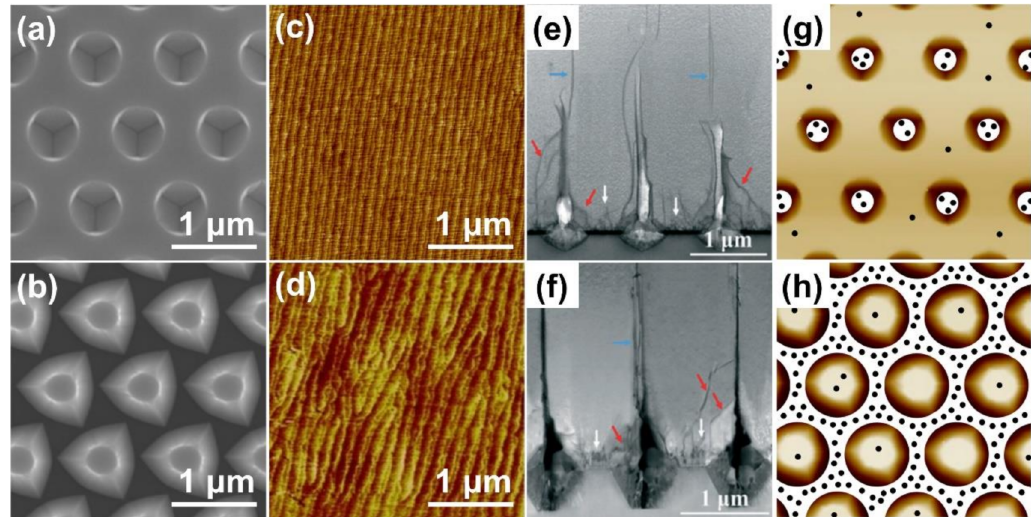
Figure 13. Plan-view SEM images of ( a ) hole-type and ( b ) pillar-type NPSS. Plan-view AFM images of ELOG-AlN grown on ( c ) hole-type and ( d ) pillar-type NPSS. Cross-sectional STEM images of ELOG- AlN grown on ( e ) hole-type and ( f ) pillar-type NPSS. Plan-view schematic diagram of dislocation distribution near the coalescence boundaries for ELOG-AlN grown on ( g ) hole-type and ( h ) pillar-type NPSS. Reprinted from [63] with copyright